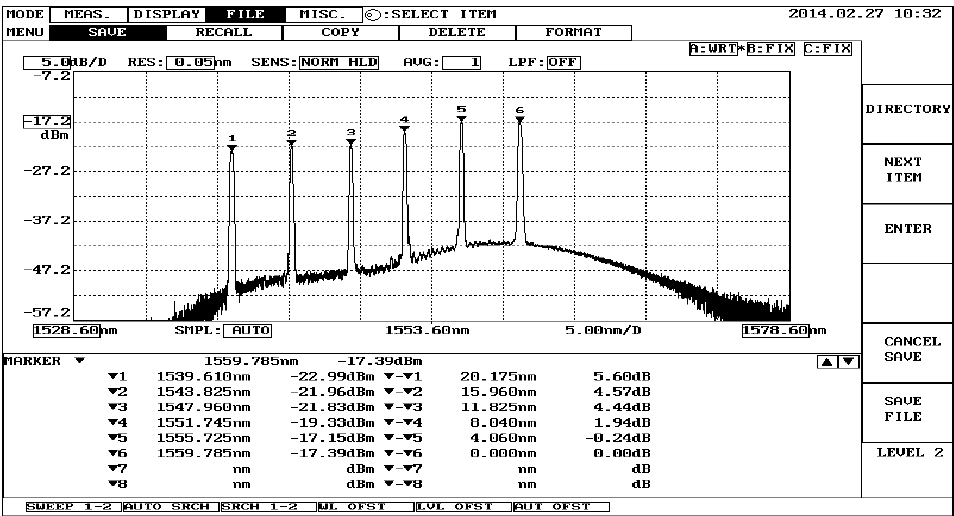
Figure 3. The reflection wavelength spectrum of six FBGs without any stress.